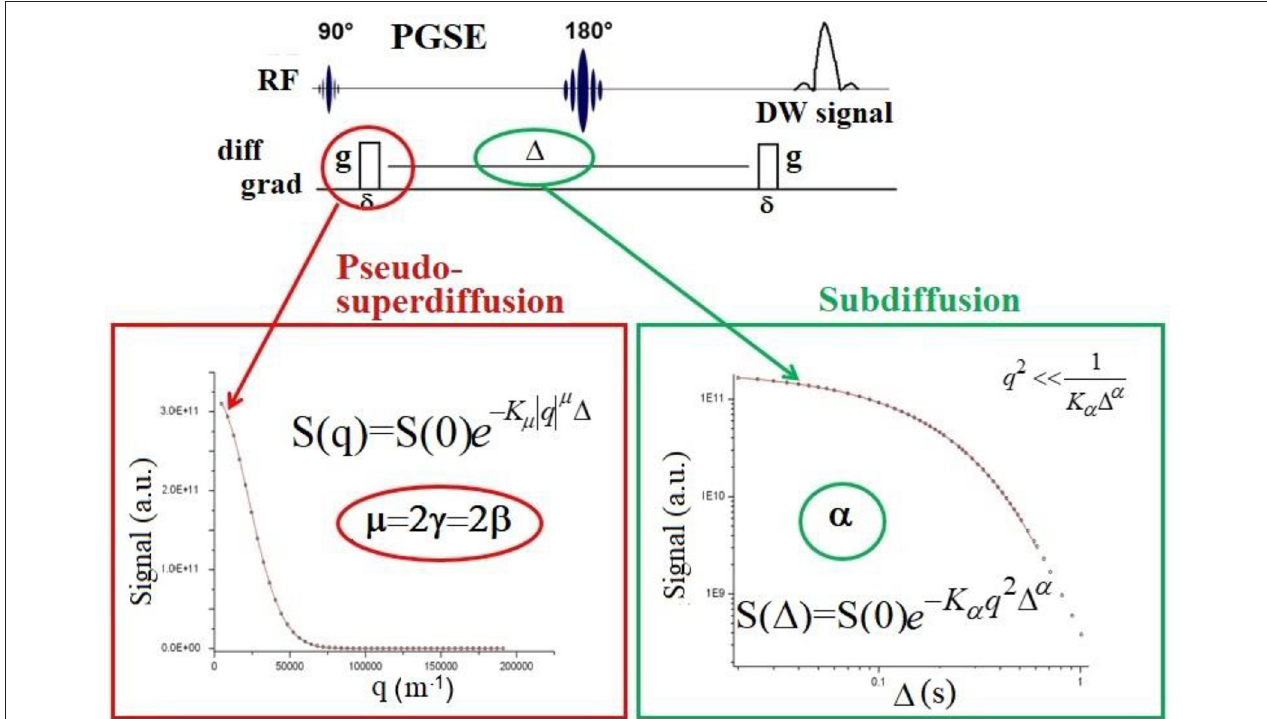
FIGURE 1 | Schematic representation of the PGSE sequence at a given b-value, where δ is the diffusion gradient pulse width. By changing the gradient strength g at a fixed value of diffusion time 1 , the DW-signal decay must be fitted to the function displayed in red box, which is the correct signal representation describing superdiffusion processes. Please note that this function depends on q µ , where q = ( γ g δ )1/2 π and µ is the index that quantifies superdiffusion [15, 19] or the space derivative order. In literature, the µ index is also indicated as γ or β , where µ = 2 γ = 2 β . Conversely, by changing 1 value at a fixed g, the DW-signal decay must be fitted to the function displayed in green box, which depends on 1 α , where the index α quantifies subdiffusion phenomena, or the time derivative order. It is important to pay attention to PFG acquisition modality and to the corresponding signal representation to fit data. The vast majority of clinical MRI scanners allow to acquire the DW-signal by varying the gradient strength